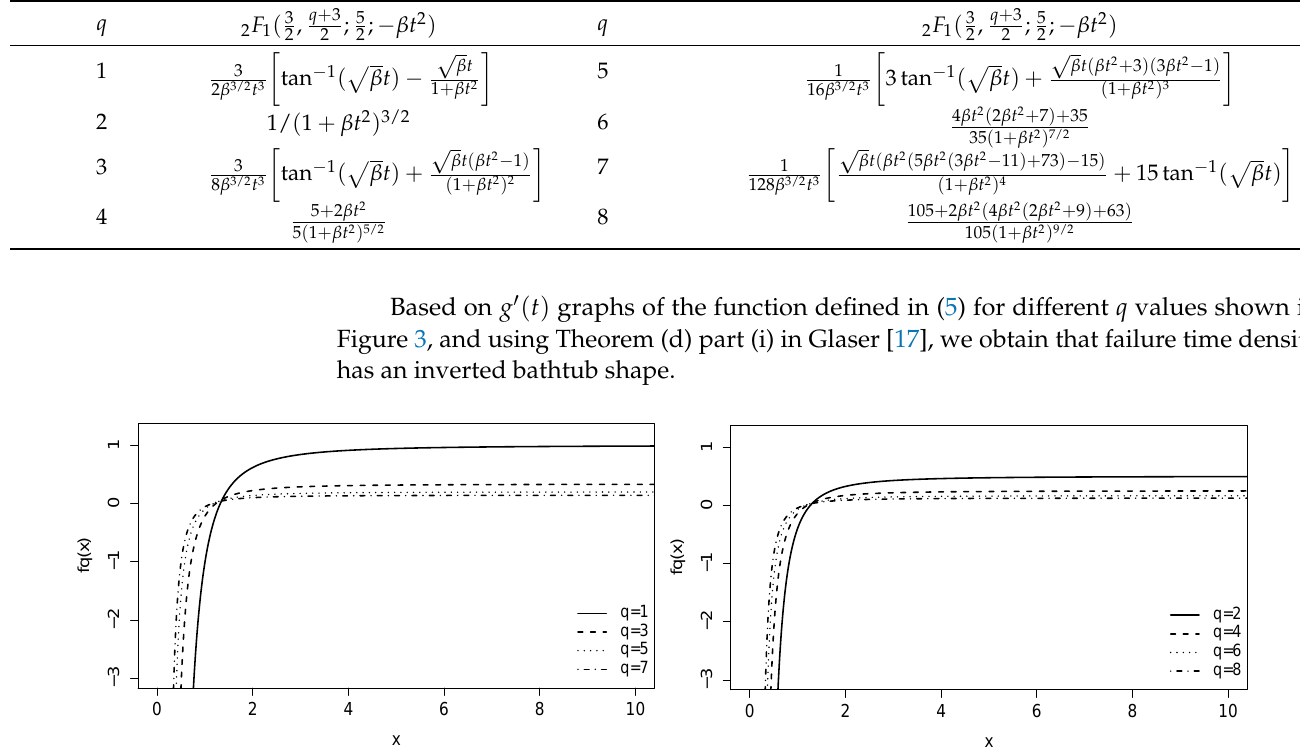
+ 3 , q ; 5 ; − β t 2 ) for different q values. 2 2 2